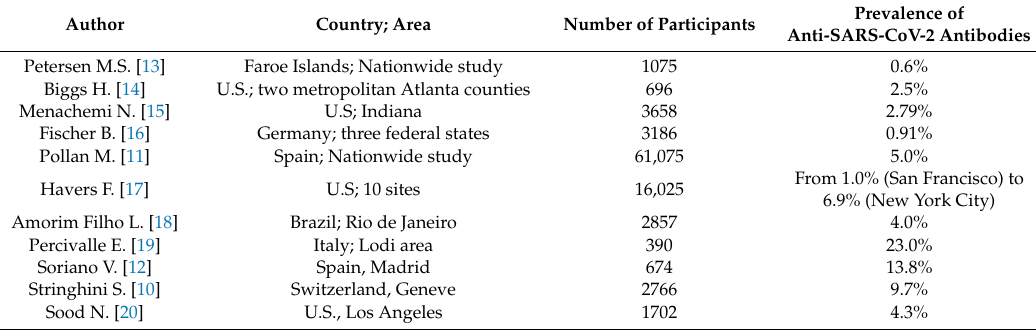
Table 5. Summary of articles published in the literature reporting data regarding prevalence of SARS-CoV-2 antibodies in the general